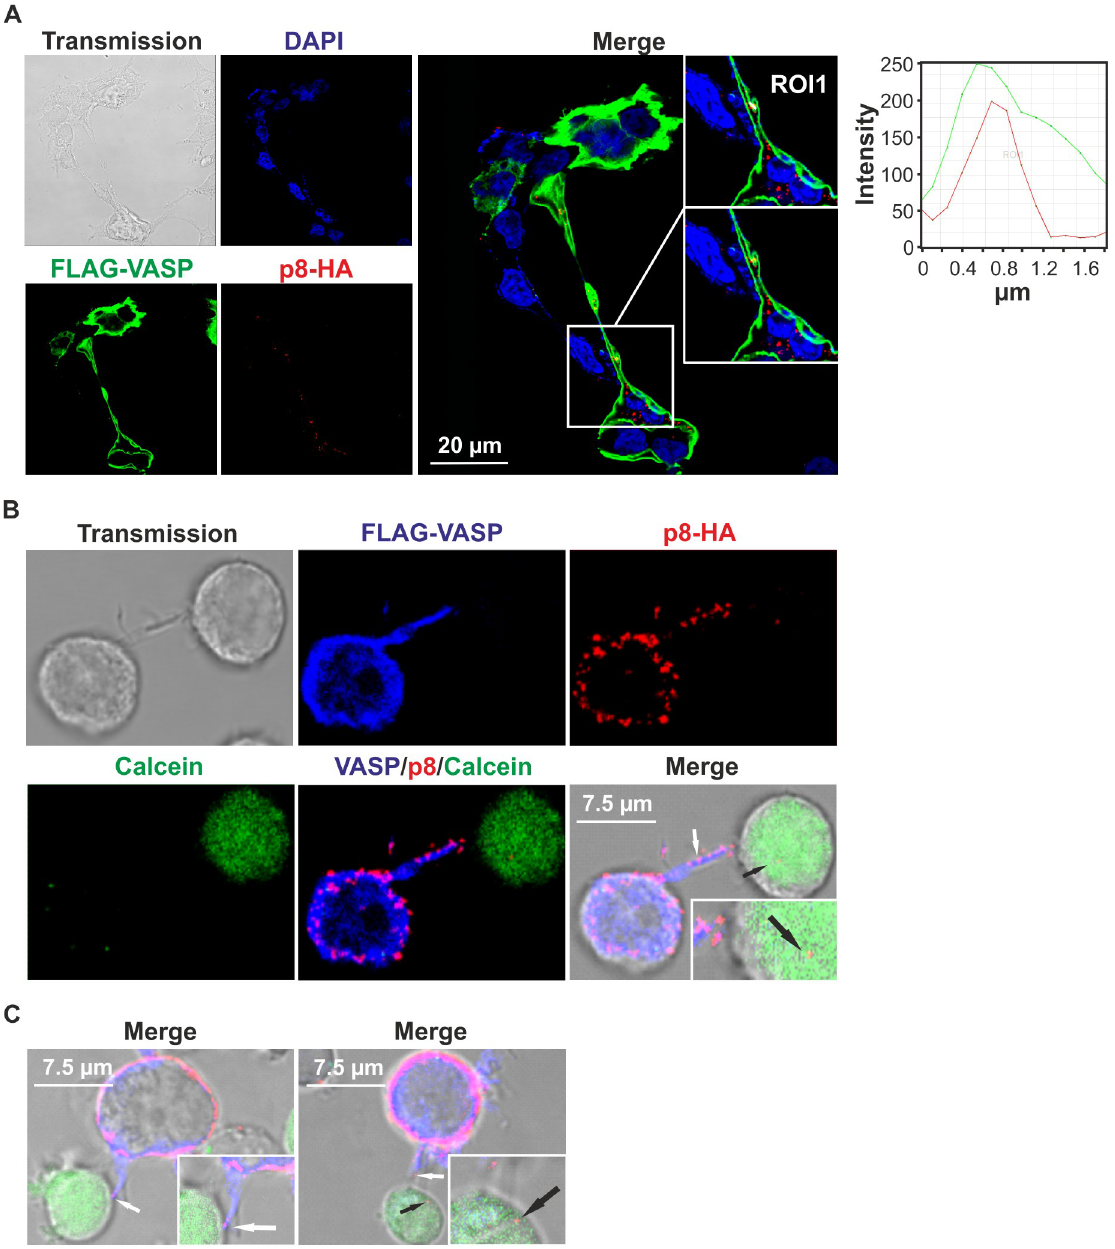
Fig 5. p8 and VASP partially co-localize in protrusive structures between cells and p8 is transferred to target T-cells via VASP- containing protrusions. (A) Confocal laser scanning microscopy of 293T cells upon co-transfection of p8-HA and FLAG-VASP expression plasmids. Stains of FLAG-VASP (green), p8-HA (red), the cell nuclei (DAPI, blue), the merge of all three stains and transmitted light are shown. Regions of interest (ROI) within a protrusive structure are shown and graphs show the fluorescence intensities of FLAG-VASP- and p8-HA-specific fluorescence along the ROI. (B) Jurkat T-cells were co-transfected with expression plasmids p8-HA, FLAG-VASP and pMACS-LNGFR. After 48 h, transfected cells were enriched by magnetic separation using LNGFR-specific microbeads and co-cultured with untransfected Jurkat T-cells pre-stained with the live cell marker Calcein (green) on poly-L-lysine-coated coverslips for 30 min at 37˚C. Immunofluorescence stainings of FLAG-VASP (blue), p8-HA (red), the merge of all stainings and transmitted light are depicted. White arrow: p8 co-localizing with VASP in a protrusion; black arrow: p8 in co-cultured target Jurkat T-cell. (C) Two additional examples of merges showing p8 co-localizing with VASP in a protrusion (white arrows) and p8 in co-cultured target Jurkat T-cells (black arrows) as described in (B)